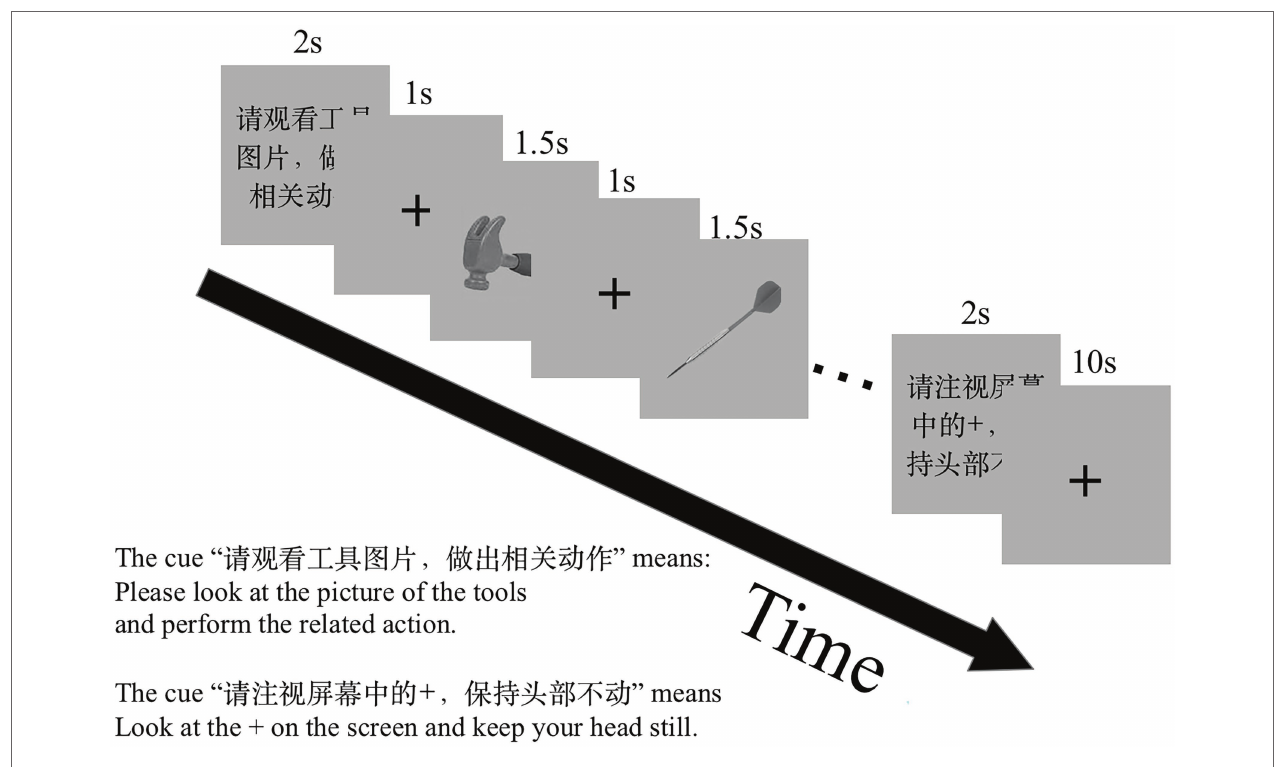
FIGURE 1 | The functional MRI (fMRI) experiment paradigm design. There were two scan runs in this experiment. One run comprises three tasks: NAM, to silently name an object picture; GenA, to perform a hand gesture to an object picture; GenV, to silently generate a verb to an object picture. Before the task block, a visual cue was presented to prompt the